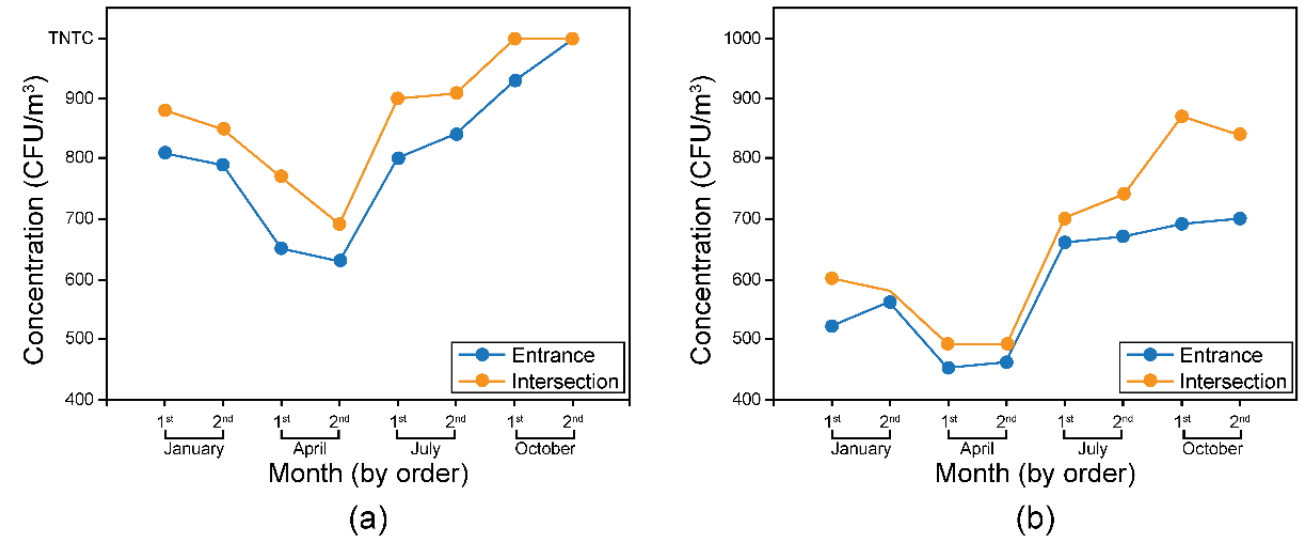
Figure 4. Concentrations of airborne microorganisms at the entrance and intersection of the market: ( a ) bacteria; ( b ) fungi.